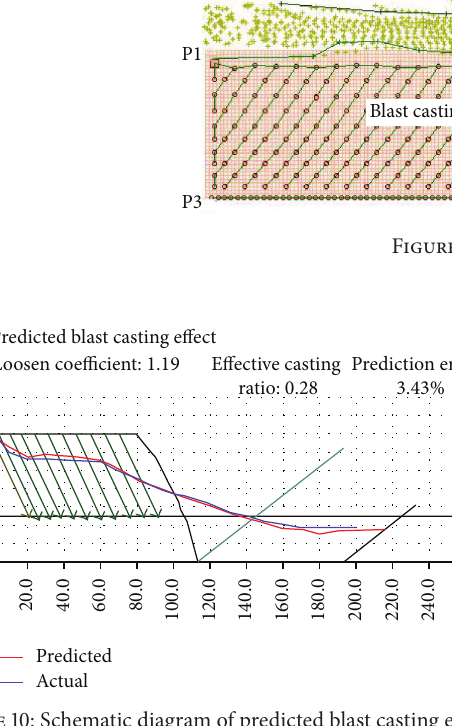
Figure 10: Schematic diagram of predicted blast casting effect.